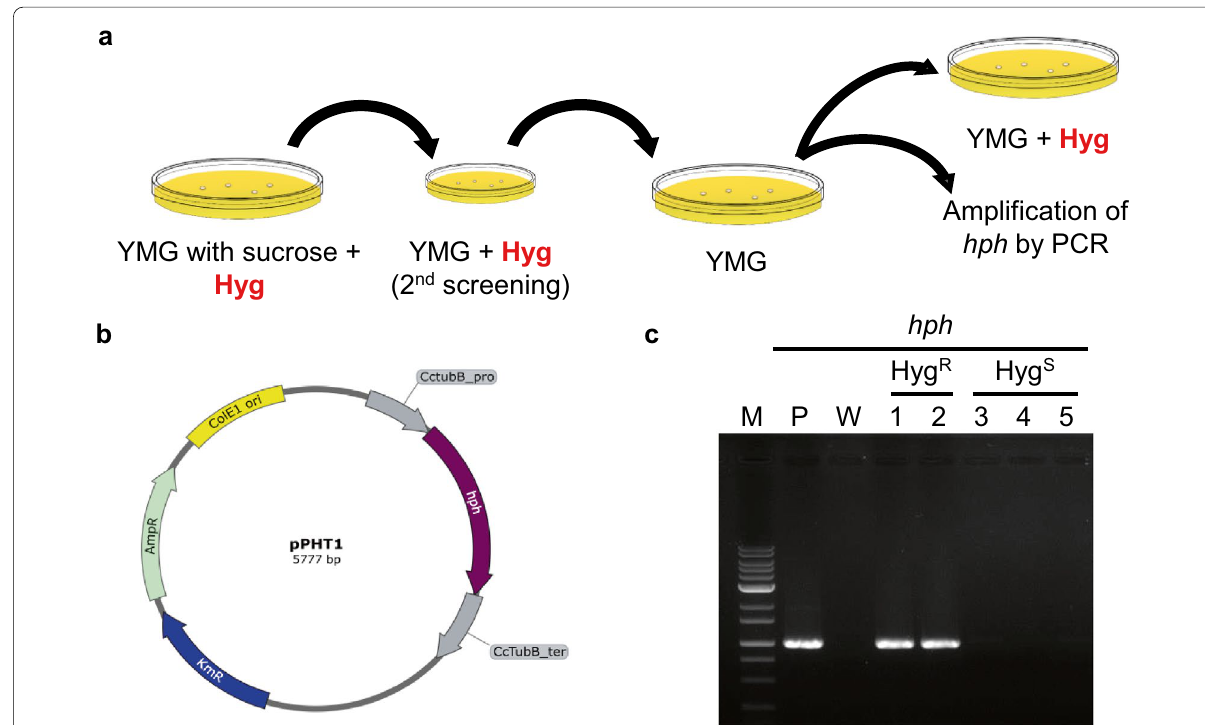
Fig. 1 Transient hph expression in Pleurotus ostreatus . a Schematic diagram for transient hph expression. b Plasmid map of pPHT1. CctubB_pro or ter: promoter or terminator from tubulin gene in Coprinopsis cinerea , ColE1 ori: origin for Escherichia coli , KmR: kanamycin resistance gene, AmpR: ampicillin resistance gene, hph : hygromycin phosphotransferase. c PCR amplification of hph fragment using primer set hph_F and hph_R. Lane M, 1-kb ladder (Nippon gene); lane P, pPHT1 (positive control); lane W, parental strain PC9 (negative control); lanes 1–5, PHT1-1–5 strains. Hyg R : hygromycin B resistant, Hyg S : hygromycin B